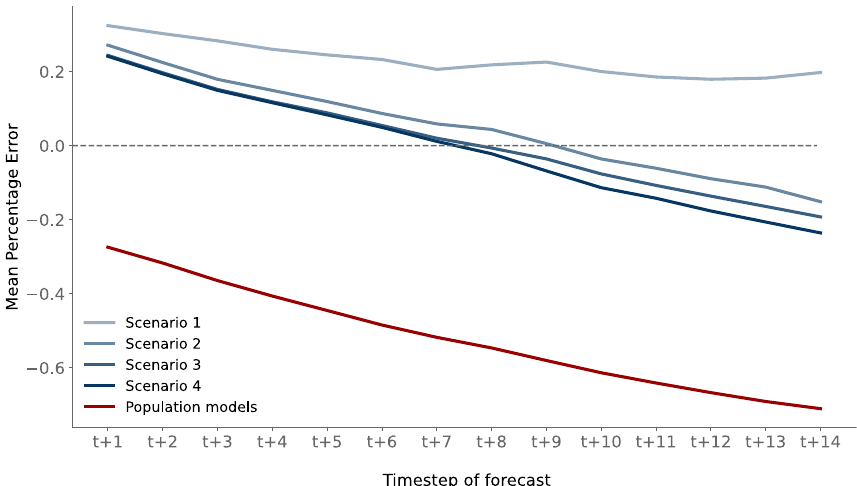
Figure 10. MPE for each time step of the forecast, grouped by model family, for the Spain case in the test split. ML models are shown for the 4 different